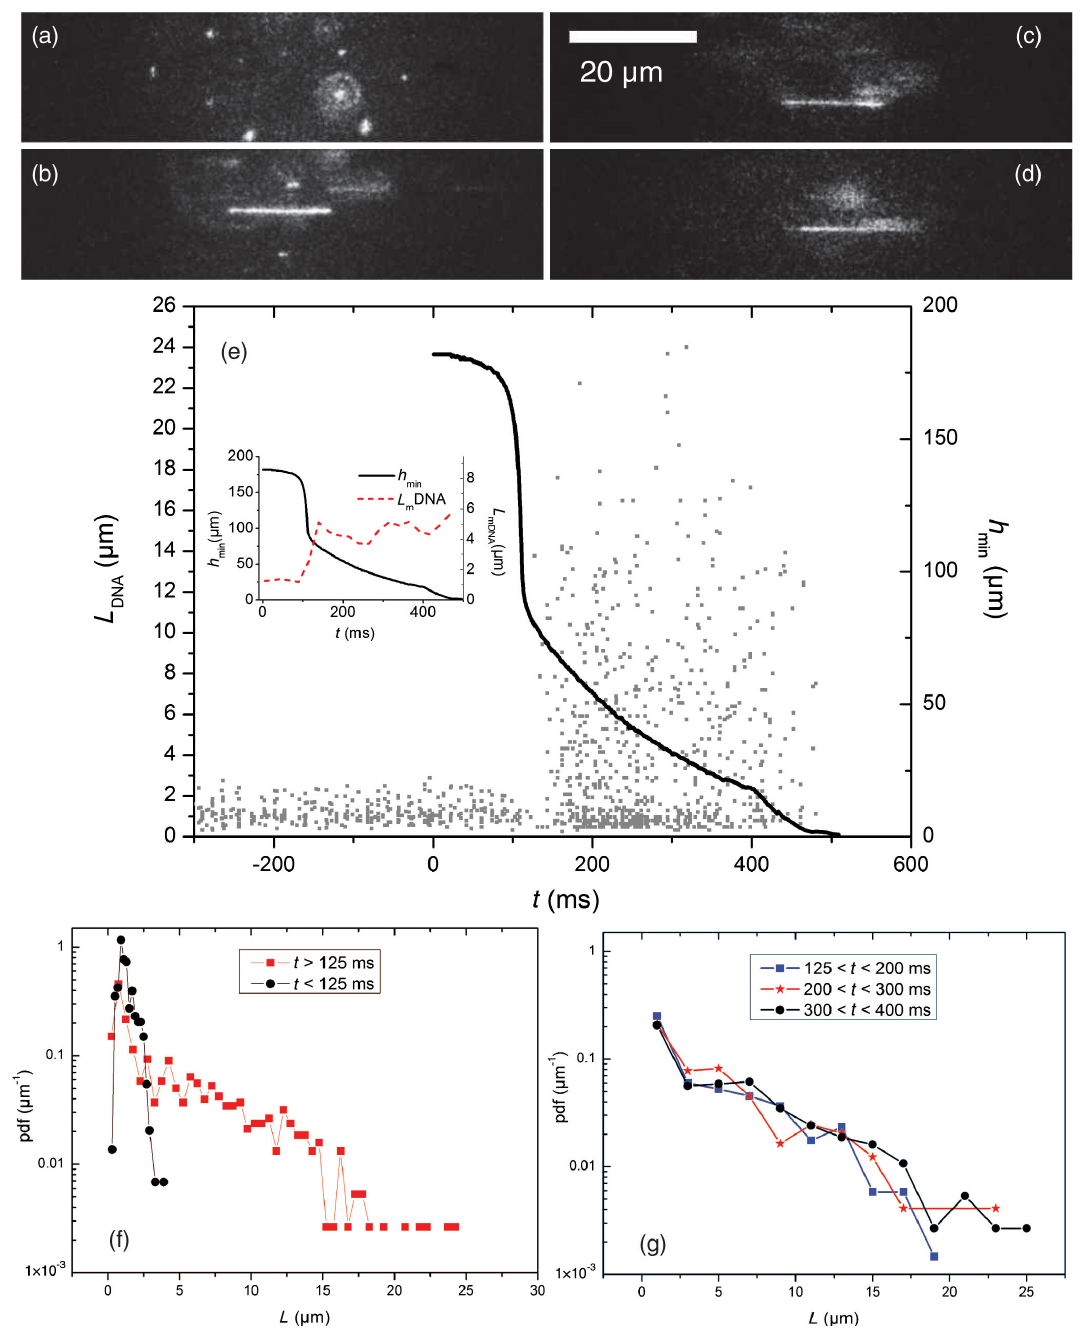
FIG. 2. Molecular extensions: (a) Coiled DNA molecules in the drop. (b) Coiled and stretched DNA molecules during the exponential thinning regime. (c) and (d) The same molecule at two different times separated by 130 ms. (e) h DNA lengths L (squares). The data points for L correspond to several runs from 70 different breakup events. Each run provides a few molecules for analysis at each instant of time. For each single drop event, we obtain a number of images at different times during the thinning. The data shown are the superposition of all such measurements during the thinning of the filament. Inset: h mean DNA length L m (dashed line). (f) Pdf ( L ) before (black dots) and after (red squares) the onset of the exponential regime. (g) Pdf ( L ) corresponding to three different time intervals during the exponential